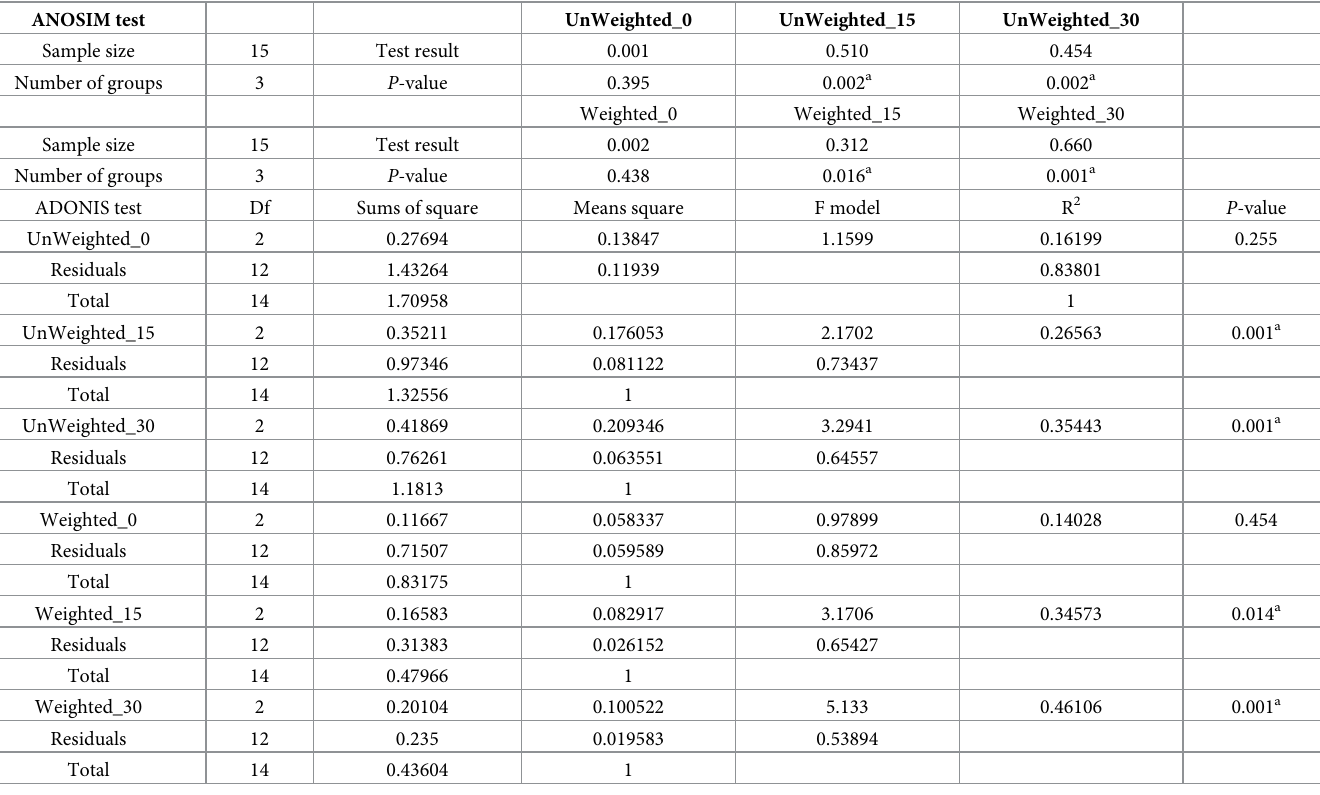
Table 3. Results for ANOSIM and ADONIS tests in the comparison of the microbiota composition for time-point and treatment. ANOSIM